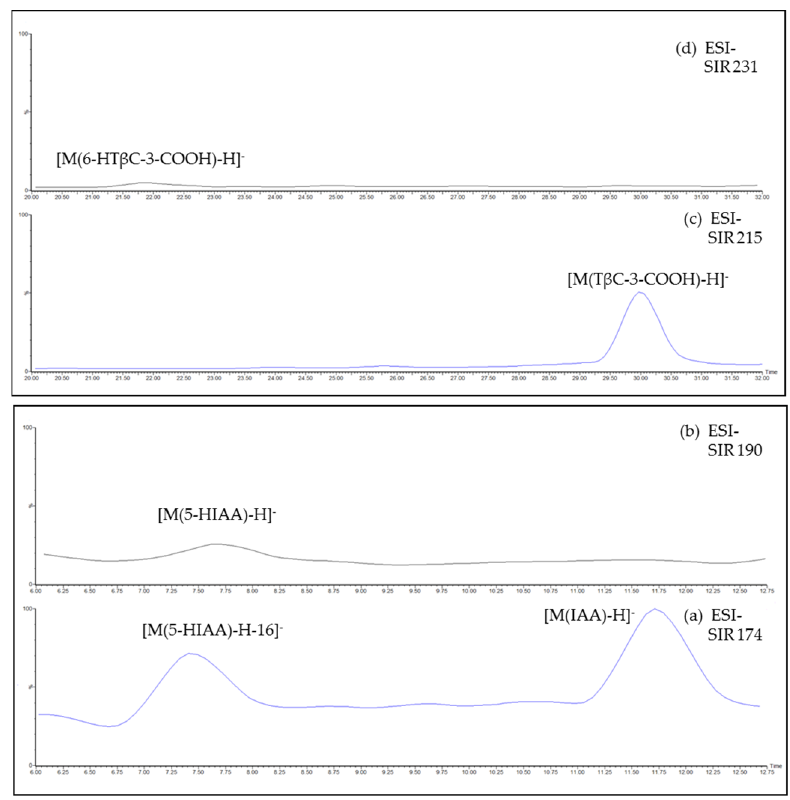
Figure 3. AR3 herbal tea, diluted 1:10 with mobile phase, ESI-SIR channels at m/z 174 ( a ), 190 ( b ), 215 ( c ) and 231 ( d ), corresponding to the ion [M-H] − of IAA ( a ), 5-HIAA ( b ), T β C-3-COOH ( c ) and 6-HT β C-3-COOH ( d ).